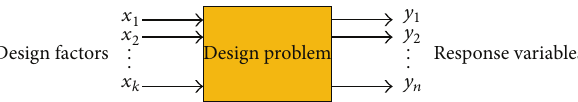
Figure 1: General model of the DOE